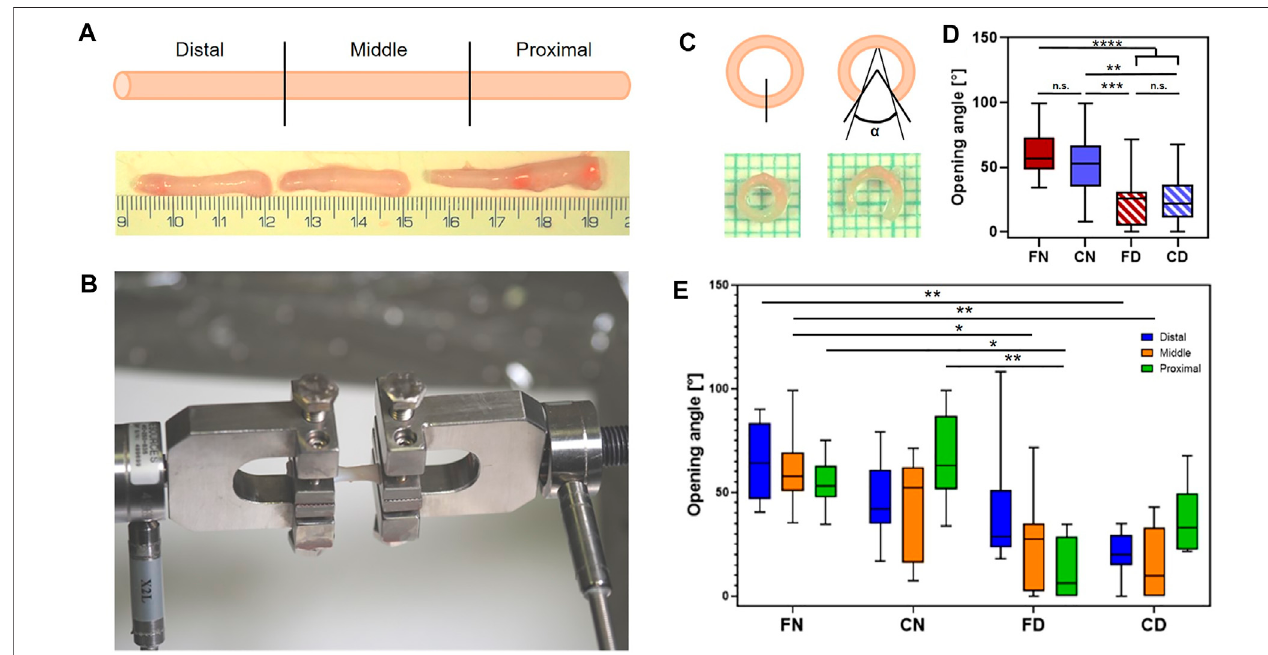
FIGURE 6 | Uniaxial tensile mechanical testing of native and decellularized vessels: (A) Scheme of the three sections of the artery (top) and image of a native artery after the division (bottom). (B) Image of the sample at the start of the load application (initial length is 10 mm); (C) scheme of the opening angle measurement (top) and imageofthesamplebefore(bottomleft)andafter(bottomright)incision; (D) boxplotoftheopeningangleforthefourgroupsoffresh/frozennativearteryordecellularized scaffold; (E) boxplot of the opening angle with a comparison between individual segments and the four groups. Abbreviations: FN, fresh native artery; CN, cryopreserved native artery; FD, freshly decellularized scaffold; CD, cryopreserved decellularized scaffold; level of signi fi cance is displayed as (*) for p < 0.05, (**) for p < 0.01, (***) for p < 0.001, and (****) for p <